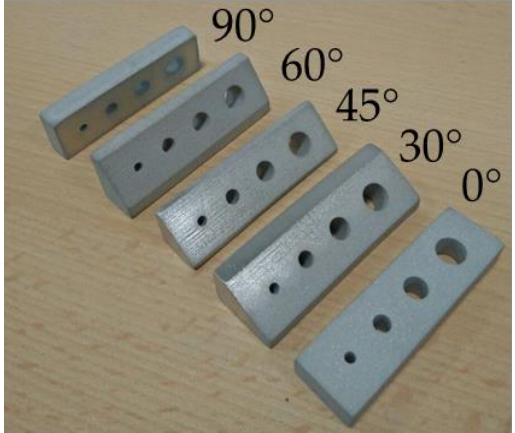
Figure 2. Sampling geometries.